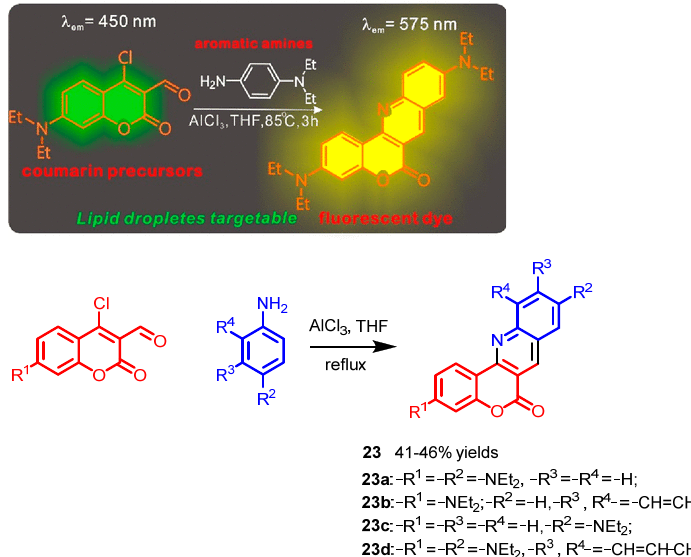
Scheme 19. Synthesis of dyes 23a − d . Adapted from [55].